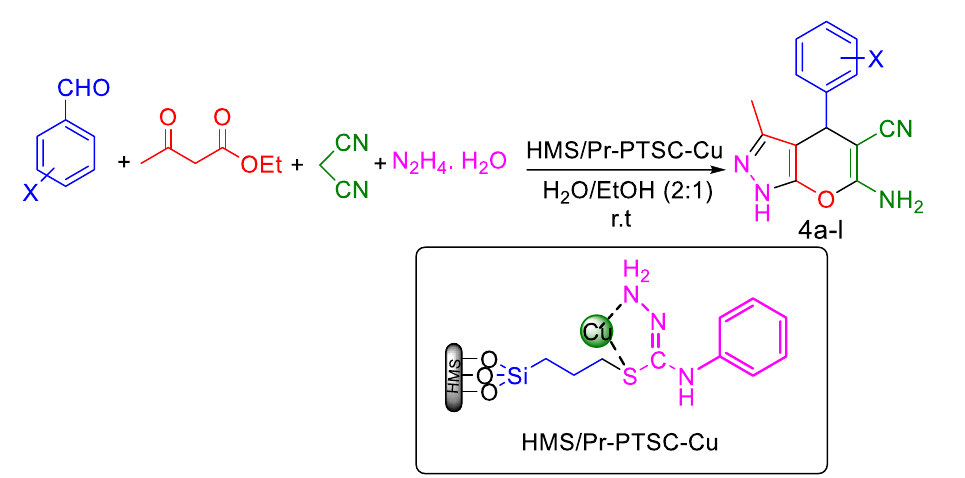
Figure 24. General procedure for the synthesis of 1,4-dihydropyrano[2,3-c]pyrazole.